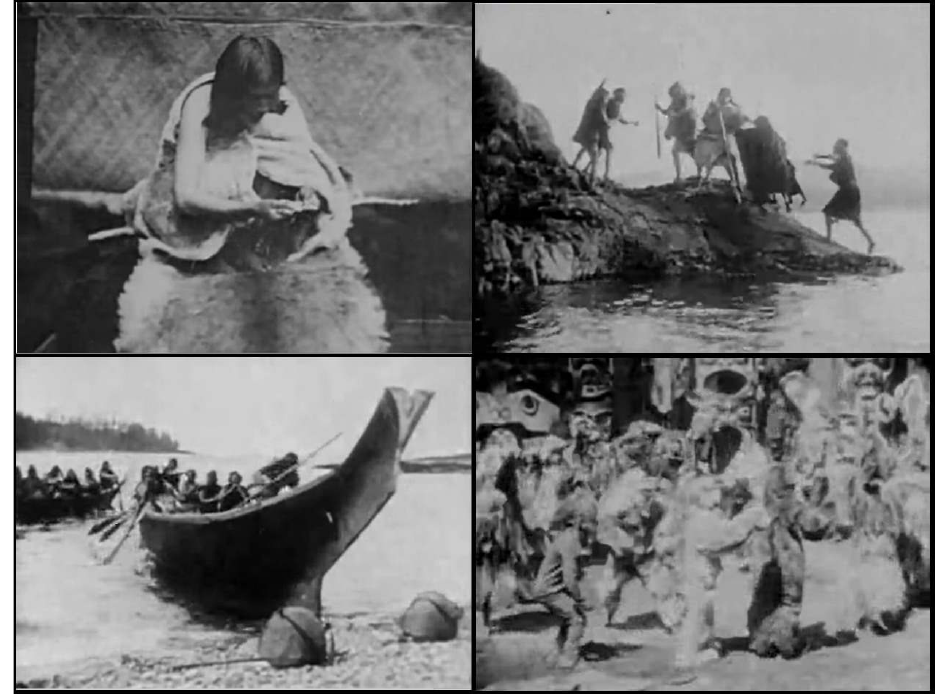
Figure 2. Stills depicting scenes from Indian daily life and traditional performances from In the Land of the Head Hunters (1914), dir. Edward S.